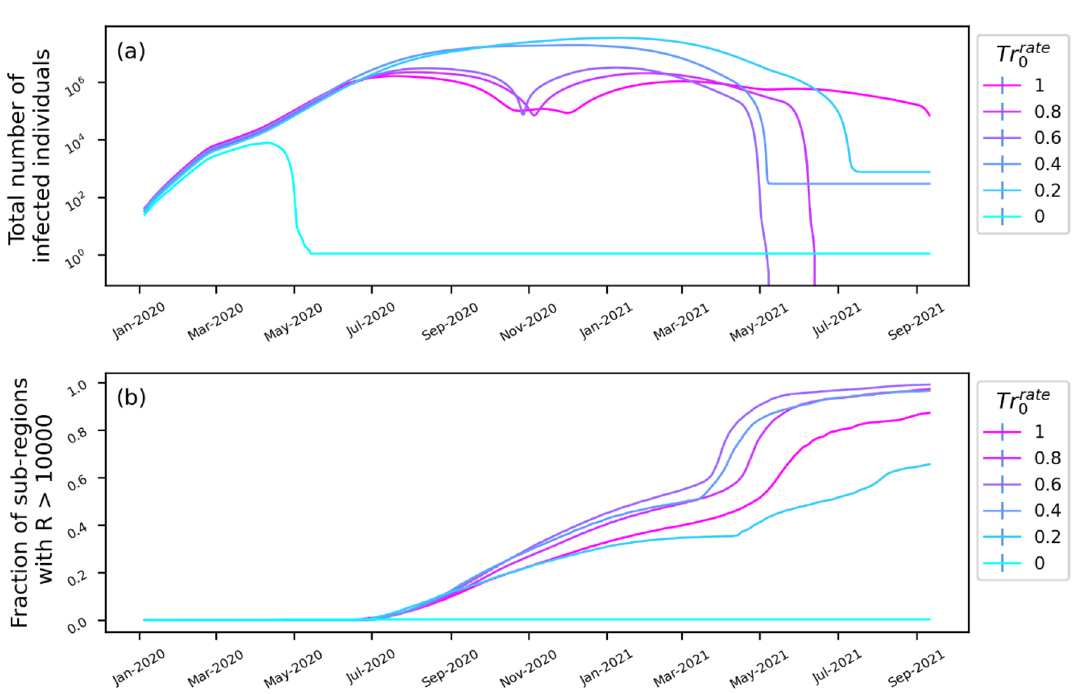
Figure 5. Role of inter-compartment movement on the spread of COVID-19 infection. The simulated change in the ( a ) total number of infected individuals (identified and unidentified) and ( b ) the number of sub-regions/ compartments with more than 1000 recovered cases as a function of the parameter, Tr Rate 0 , transfer rate between